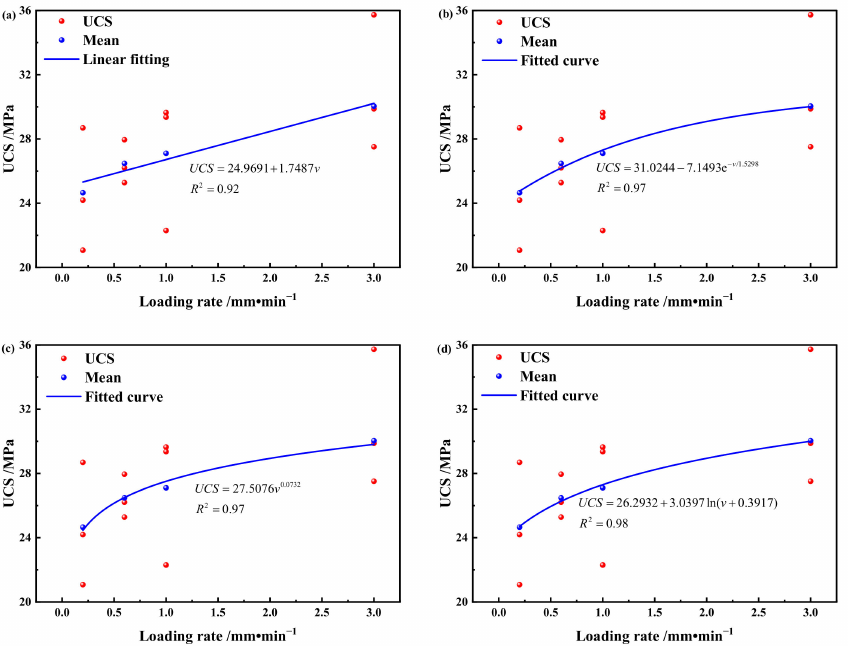
Figure 3. Correlation between compressive strength and loading rate: ( a ) Linear fitting, ( b ) Exponen- tial fitting, ( c ) Power fitting, and ( d ) Logarithmic fitting.